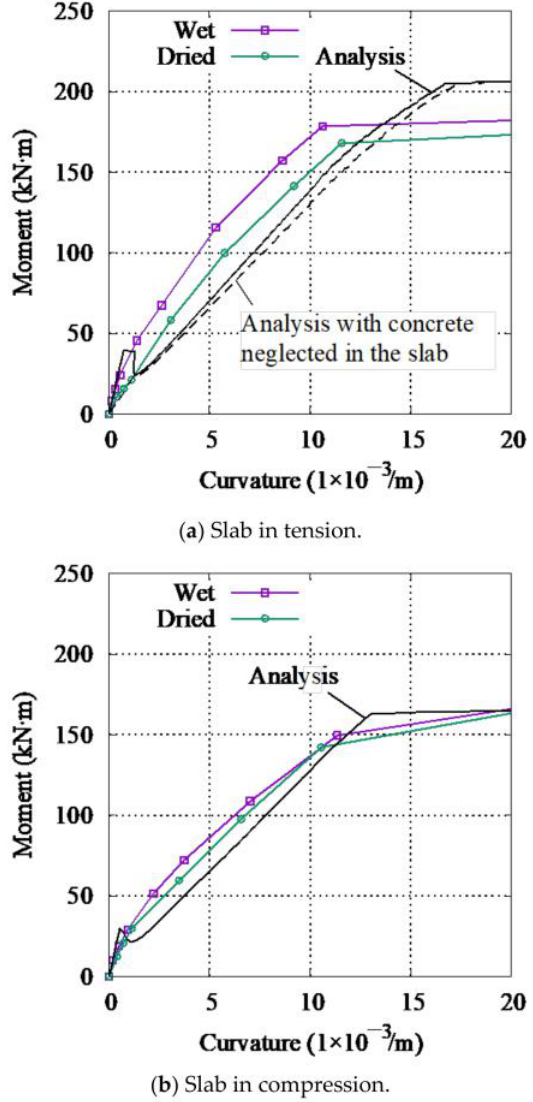
Figure 16. M − φ relationship. ( a ) Slab in tension, ( b ) slab in